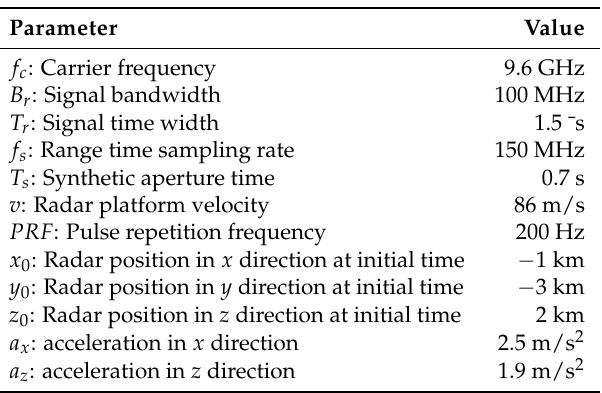
Table 1. Simulation